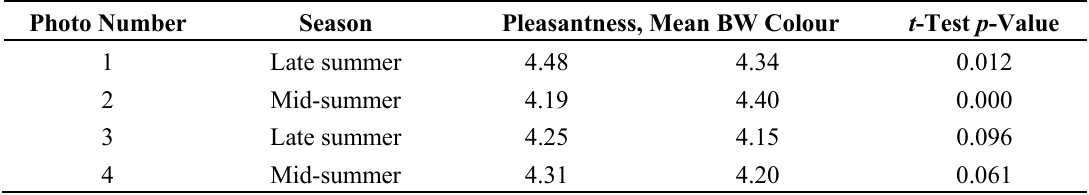
Table 5. Landscape pleasantness in black-and-white (BW) and colour photographs and the statistical significance of differences between the